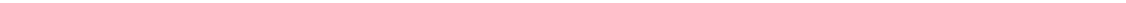
Fig. 2 In vivo reprogramming in mice using scAAV8 SFFV-hCO-O/K/S/M vectors. a Experimental setup. 38 weeks-old C57BL/6 male mice were injected with 5 × 10 10 ( n = 9) or 2 × 10 11 ( n = 9) vg per vector and mouse. 2 and 4 weeks post-injection, three mice per dose and time point were sacri fi ced, and their organs were extracted and analyzed histopathologically. Remaining mice were sacri fi ced upon appearance of palpable teratomas (week [w] 7, 8 and 10: 2 × 10 11 vg group; month [m] 9: 5 × 10 10 vg group). b Hematoxylin/eosin staining of liver teratoma section (mouse treated with 2 × 10 11 vg and